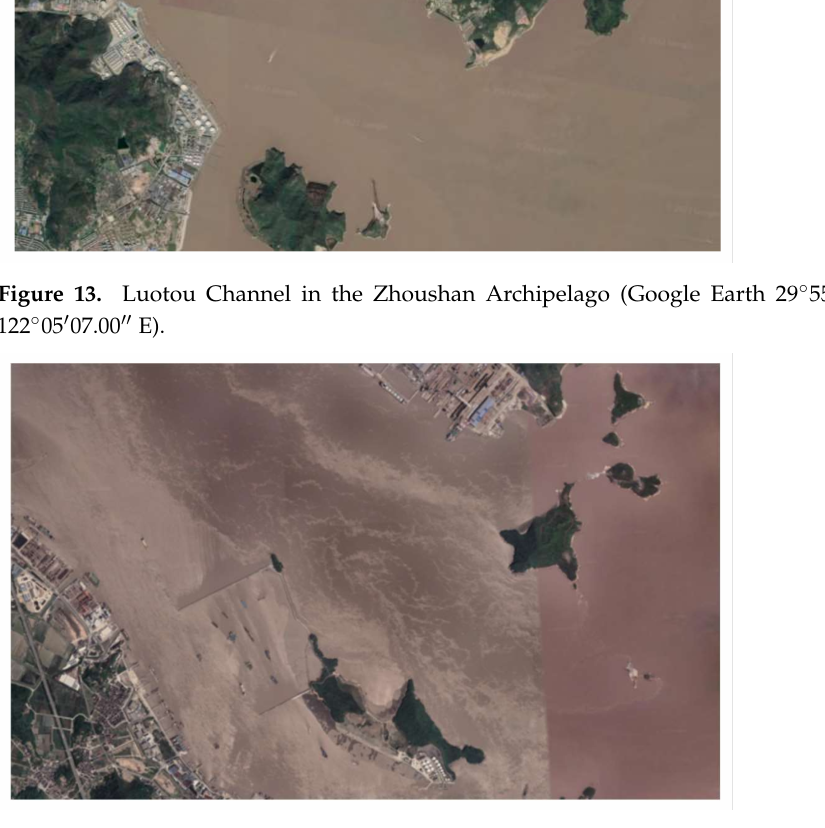
Figure 14. The water area at Zhoushan Xiushan Island (Google Earth 30 ◦ 08.00 (cid:48)(cid:48) N and 122 ◦ 08.00 (cid:48)(cid:48) E).